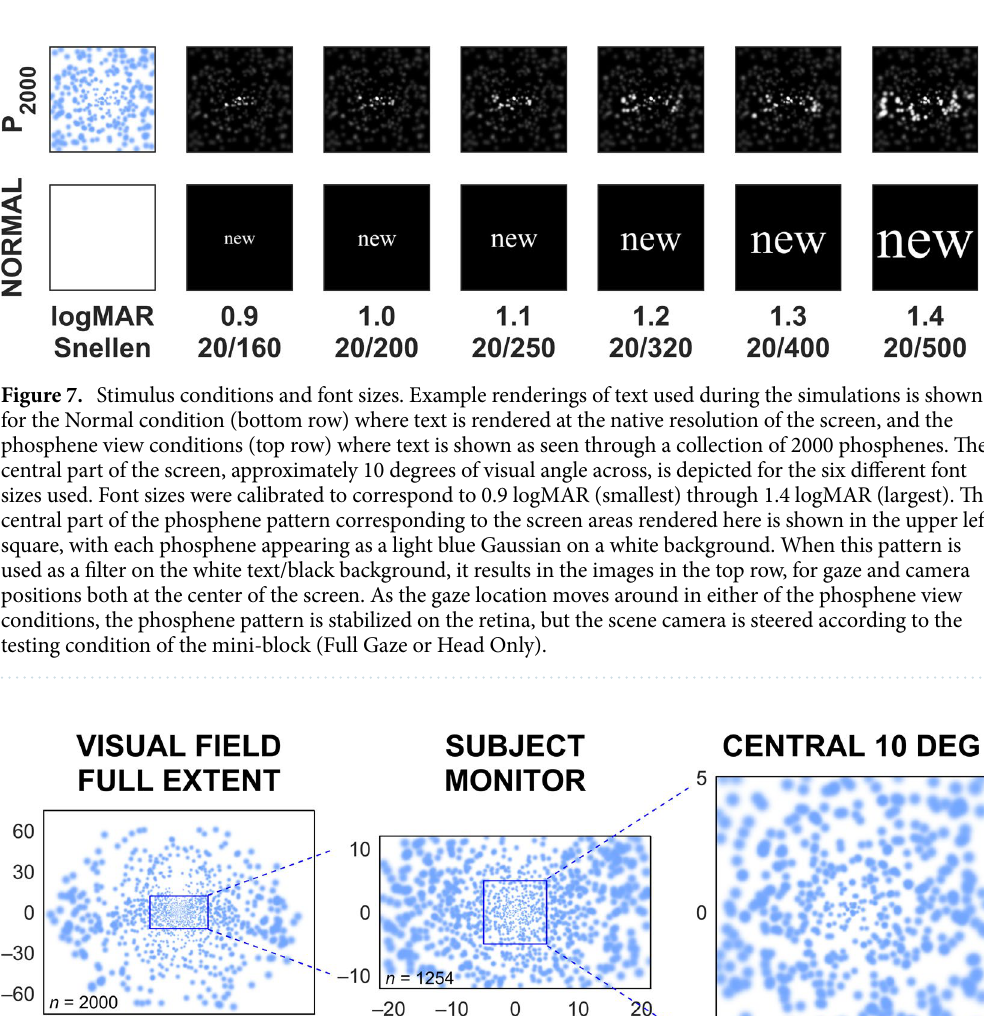
binocularly with corrective lenses if the subject normally used them, and at a pace determined by the subject. Responses were converted to logMAR units. Initial seating. After the Snellen screening, participants were brought to the experimental room, and seated comfortably in front of the subject monitor at a distance of about 70 cm from the display. Subjects wore both a bulls-eye sticker on their forehead to support frame-free gaze tracking, and a set of non-functional headphones onto which the head-tracking LED arbor was mounted. To improve the quality of tracking results, subjects were seated with their chest against the table and arms on the table to create a natural centering of head position with- out undue limits on head rotation. Instructions were given for the calibration task which was then performed, followed by instructions for the reading task which was then in turn performed.